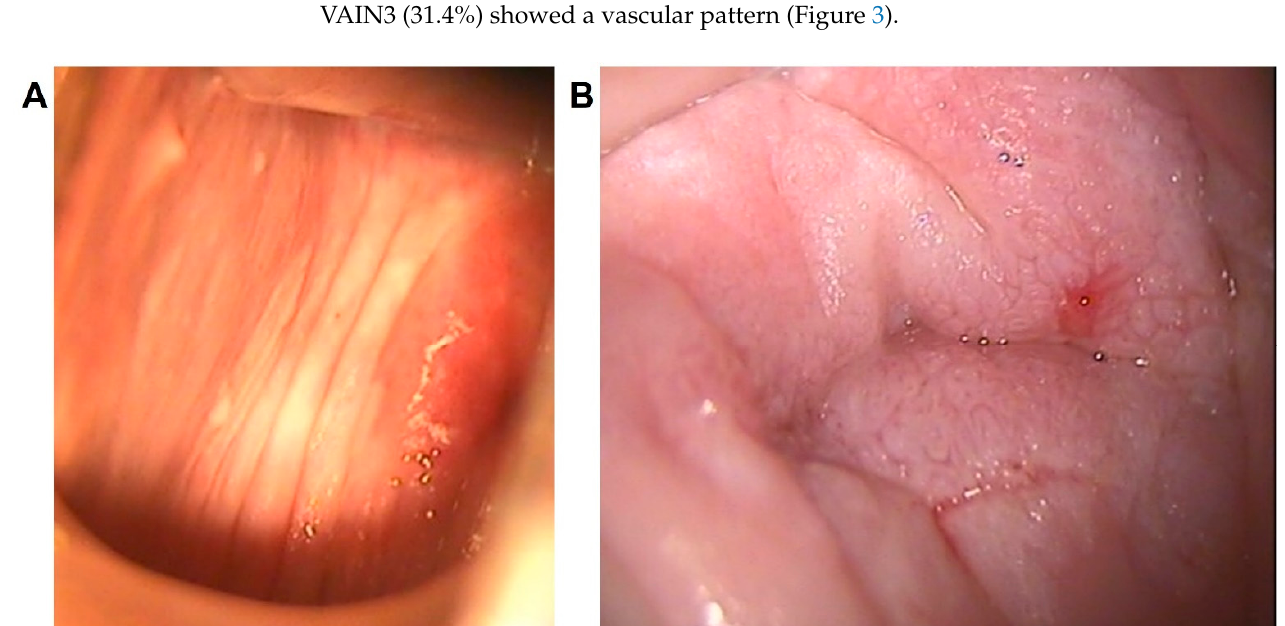
Figure 2. Papillary pattern. Multiple papillary lesions with both regular and irregular surface, located at the whole right vaginal wall in a patient diagnosed with VAIN3 at a colposcopic overview ( A ) and at a magnified colposcopic vision ( B ).